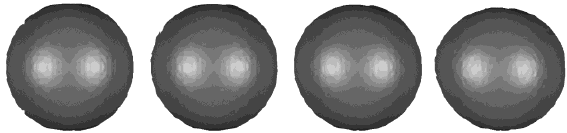
Figure 2: Sphere measurement (simulation) with  E = 0,  E = 1,  E = 2, and  E =5 (from left to right)